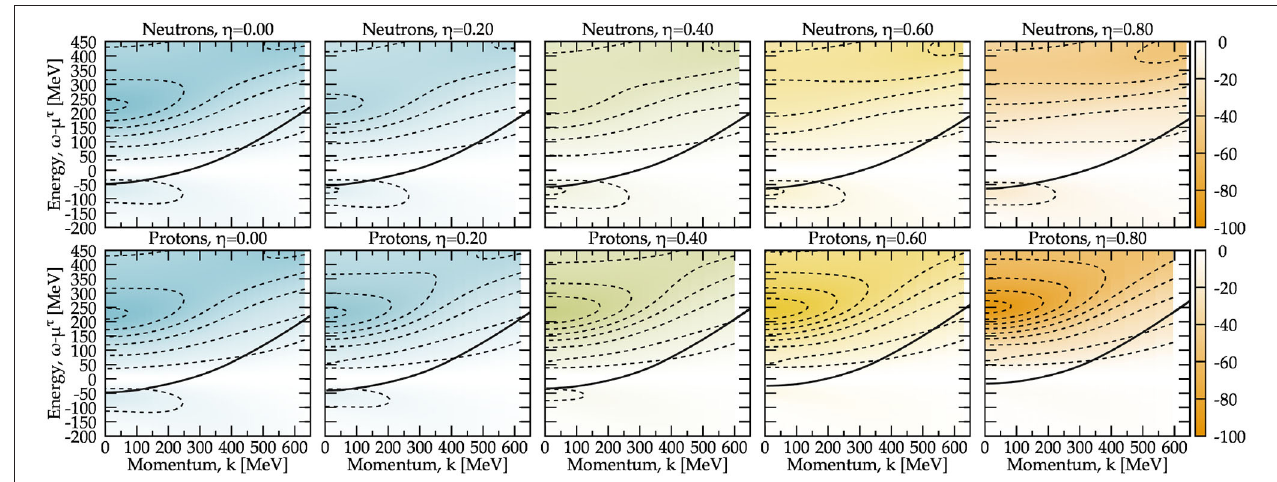
FIGURE 6 | The same as Figure 5 but in isospin asymmetric nuclear matter for the 3 = 500 MeV interaction. Top panels focus on neutrons, and bottom panels on protons. The panels from left to right correspond to different isospin asymmetries, from η = 0 (symmetric nuclear matter, leftmost panel) to the neutron-rich domain with η = 0.8 (rightmost